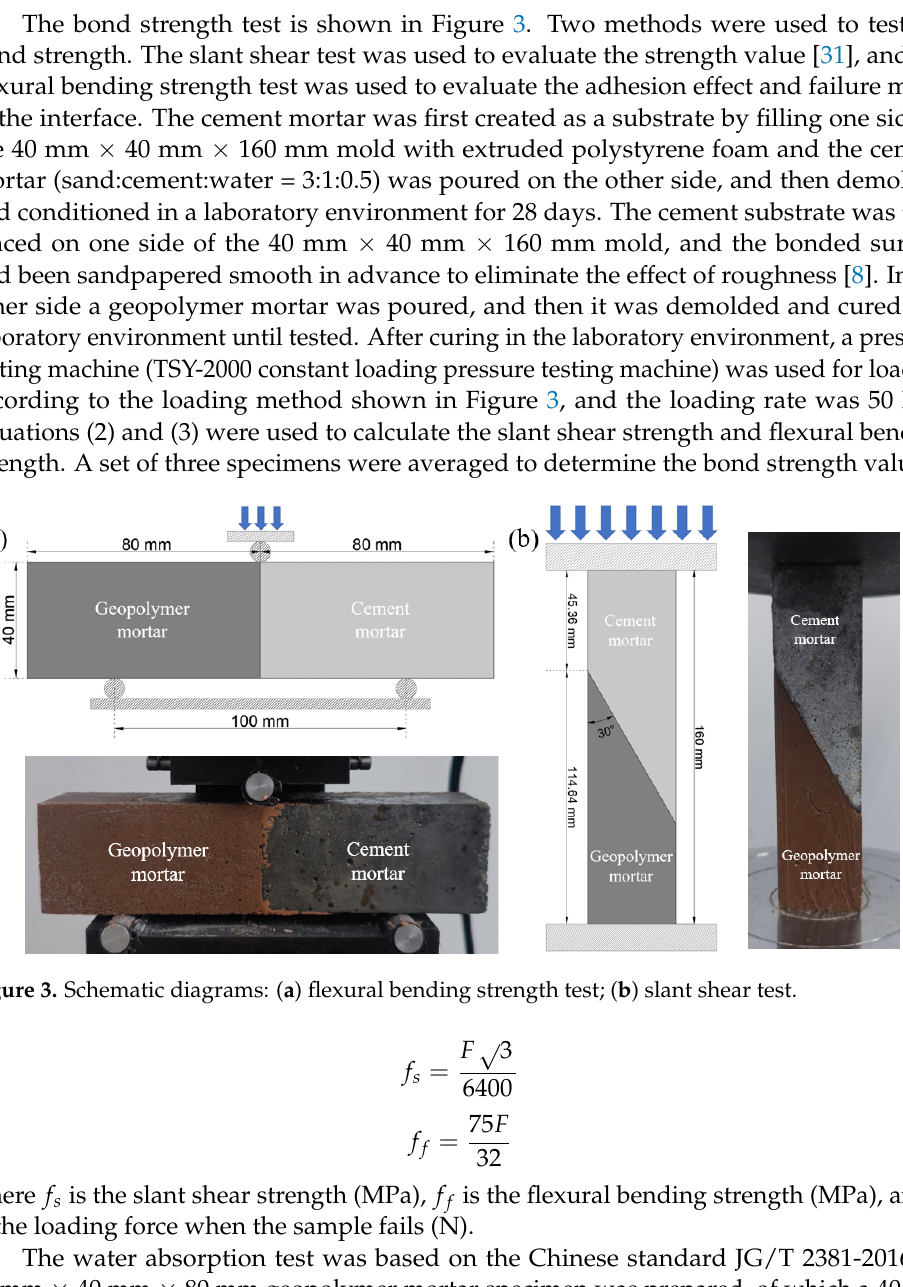
where   is the slant shear strength (MPa),   is the flexural bending strength (MPa), and F is the loading force when the sample fails (N).